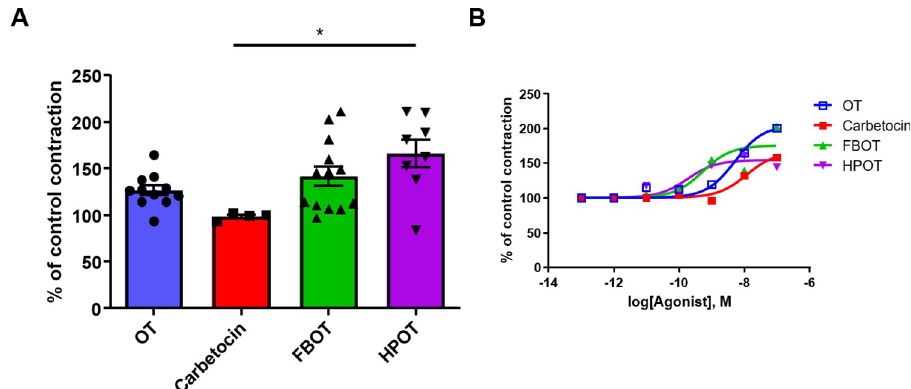
Fig 2. Strength of human myometrial contractivity. ( A ) Percentage of strength of contractivity in response to 1 nM oxytocin (OT), carbetocin, FBOT, and HPOT treatments, calculated from traces shown in Fig 1; 100% represents the area under curve (AUC) of control contractivity. � P < 0.05. ( B ) Dose response curves of OT, carbetocin, FBOT, and HPOT. Recordings of human myometrial contractivity (n = 4–13 for each point) were analyzed for AUC; 100% represents AUC of spontaneous contraction in the presence of 1 pM of each agonist. Note that symbols overlap at concentrations lower than 0.1 nM. Symbols of HPOT and FBOT overlap with those of OT at 10 and 100 nM, respectively.